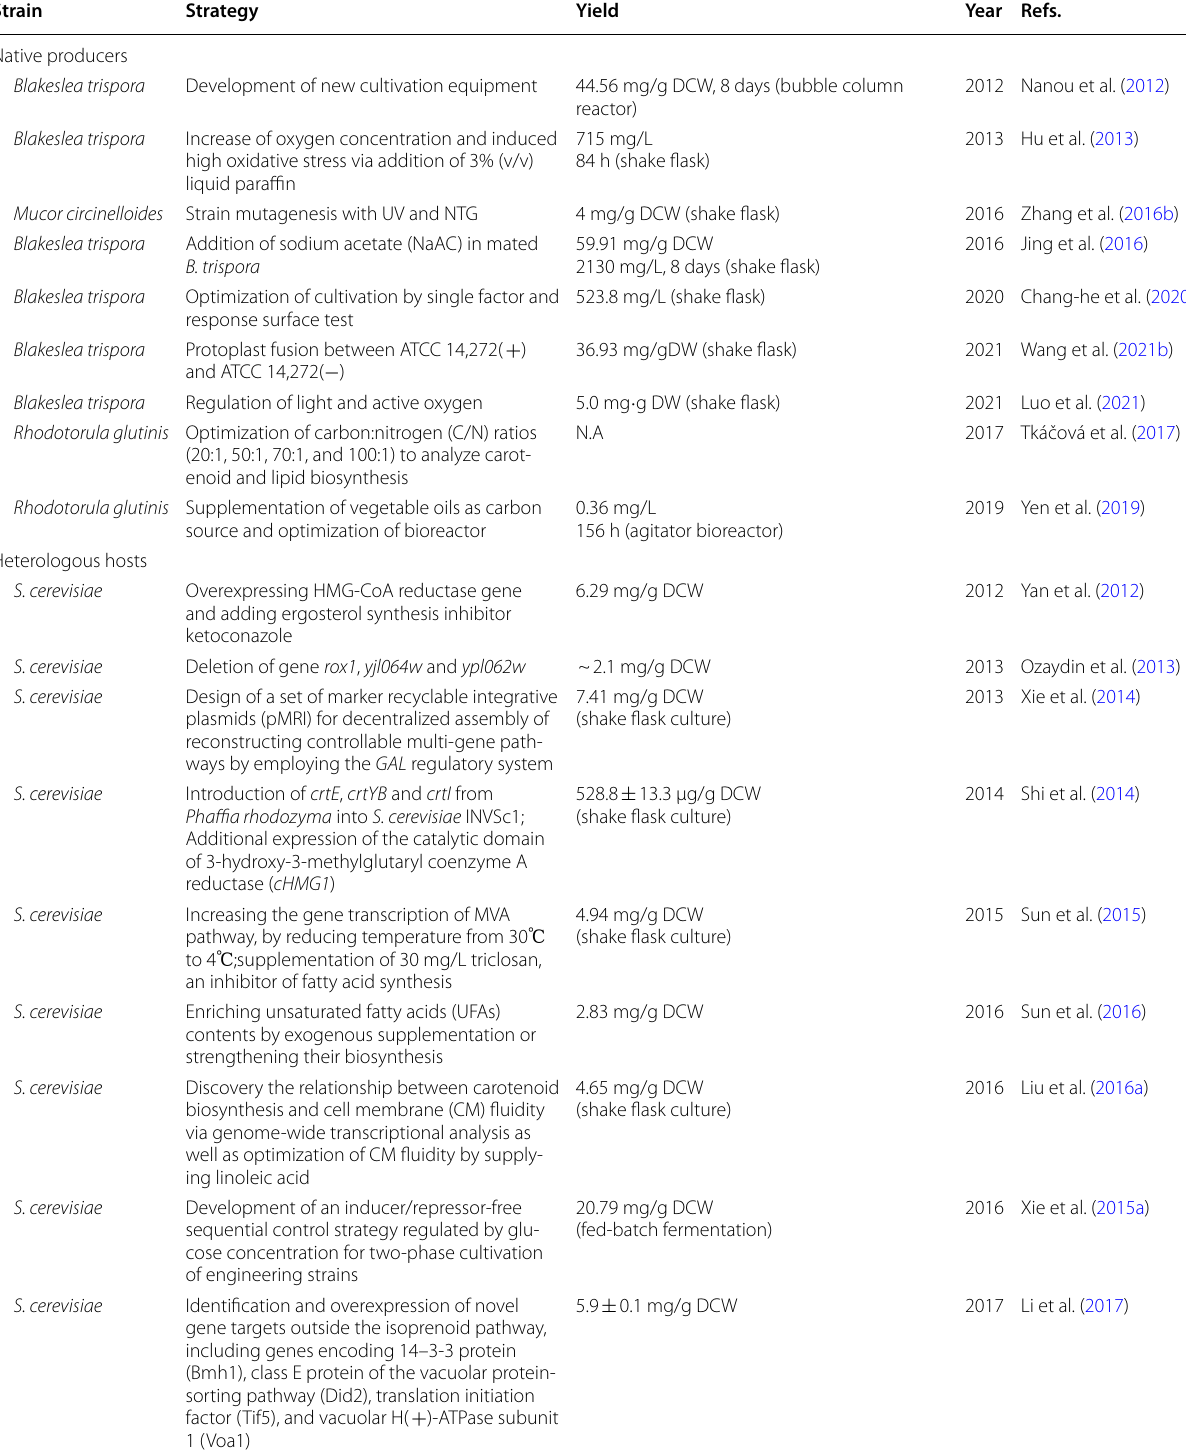
Table 1 Progresses of β-carotene biosynthesis in the last decade Strain Strategy Yield Year